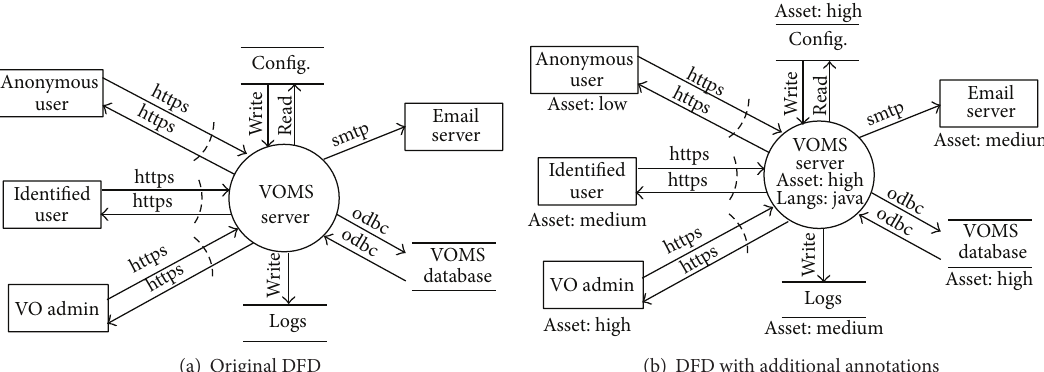
Figure 1: Original DFD compared to annotated DFD.